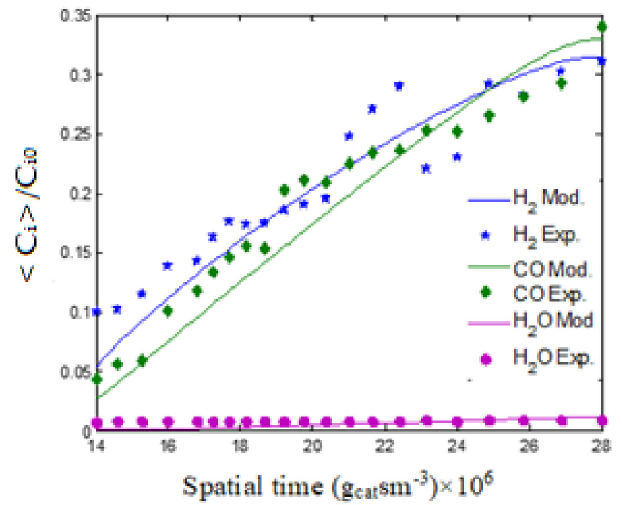
Figure 4. Evolutions of product concentrations as a function of space-time. Conditions: Ni (4.86% wt.)/ γ -Al 2 O 3 catalyst, fluidized bed (280.0 g), 1.0 bar, 973K.